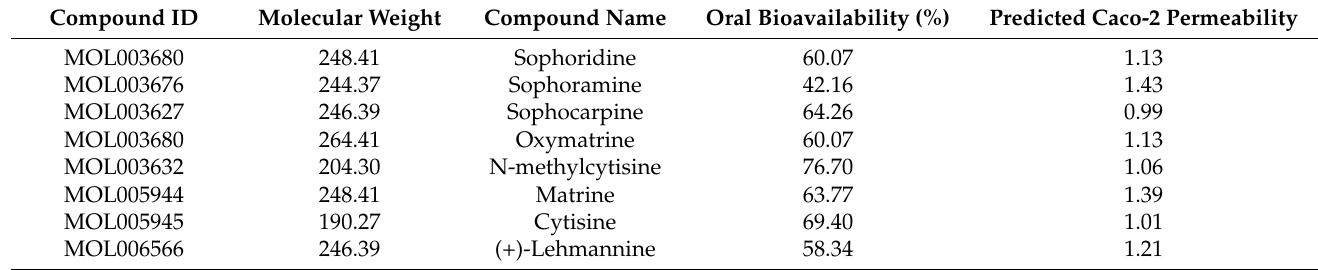
Table 2. Pharmacological and molecular properties of 8 alkaloids in S. alopecuroides . Compound